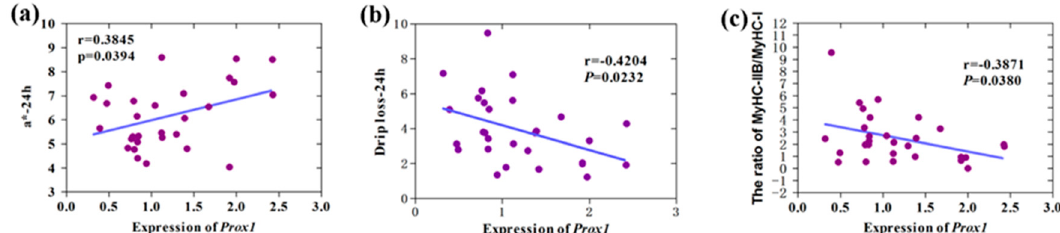
Figure 5. Correlation between porcine Prox1 expression and meat quality traits. The expression of porcine Prox1 was compared with that of myoglobin , MyHC I , MyHC IIB , and MyHC IIX in Figure 4, and the phenotype data of 32 commercial hybrid pigs are shown in Table 2. ( a ) Correlation between Prox1 expression and meat color (redness) value a * at 24 h postmortem. ( b ) Correlation between Prox1 expression and drip loss at 24 h postmortem. ( c ) Correlation between Prox1 expression and the ratio of MyHC IIB to MyHC I expression levels.